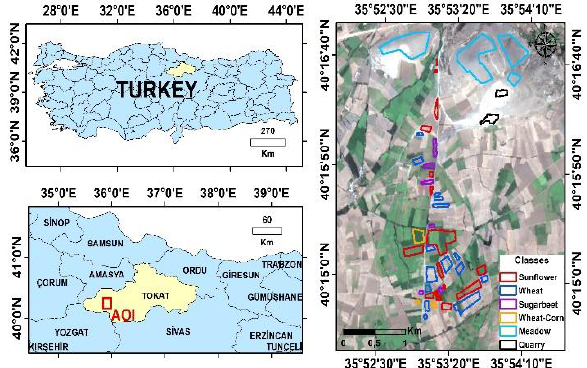
Figure 1. Illustration of the study area and annual cultivated